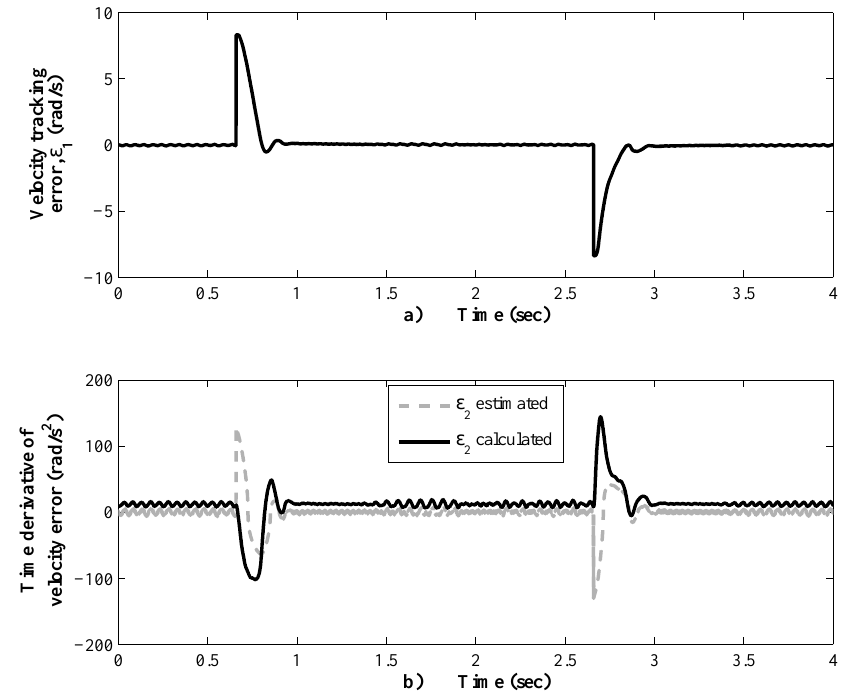
Figure 9. SOSM controller: ( a ) velocity tracking error ε 1 , and ( b ) time derivative of the velocity tracking error ε 2